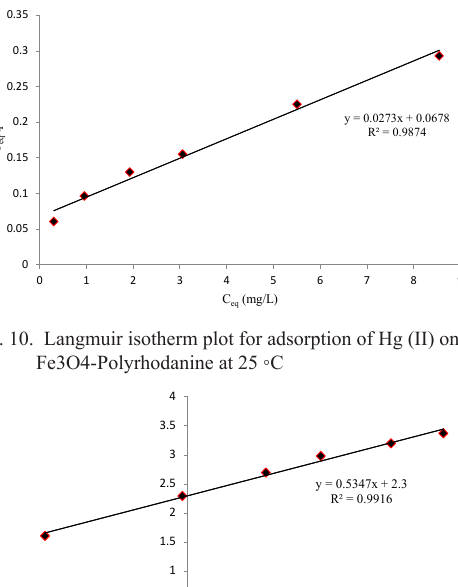
y = 0.5347x + 2.3 R²=0.9916